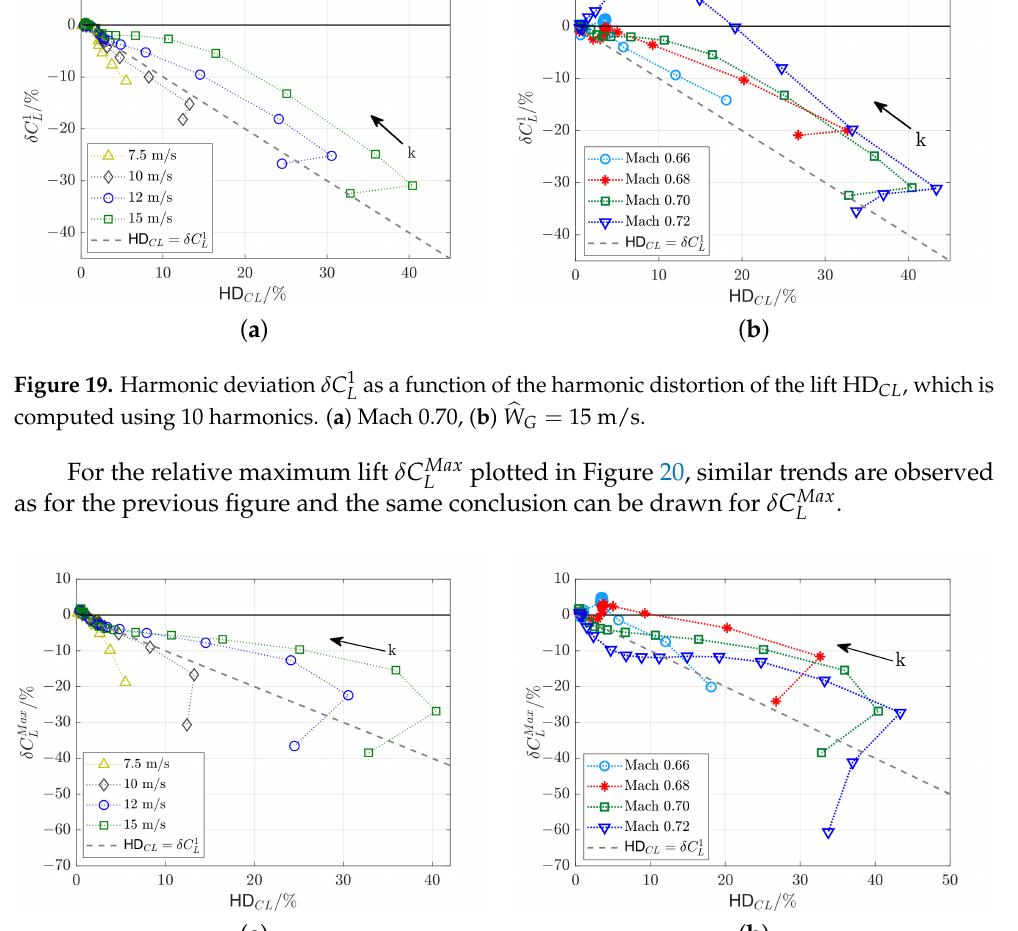
Figure 20. Relative maximum lift δ C Max as a function of the harmonic distortion of the lift HD CL , L which is computed using 10 harmonics. ( a ) Mach 0.70, ( b ) (cid:98) W G = 15